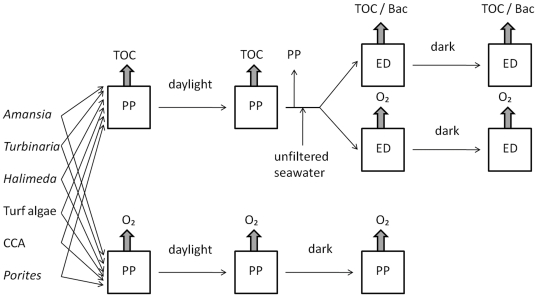
Experimental setup.Primary producers were incubated in filtered backreef seawater in replicates of a minimum of five for each species. Following the 8.5 h daylight DOC release incubations specimen were removed and reference parameters were determined and unfiltered backreef seawater was amended to add a representative microbial community for subsequent dark incubations (48 h) of the exudates. Thick arrows indicate measurements of respective parameters. Abbreviations: PP = primary producer, ED = exudate dilution, TOC = total organic carbon, Bac = bacterial cell abundance.